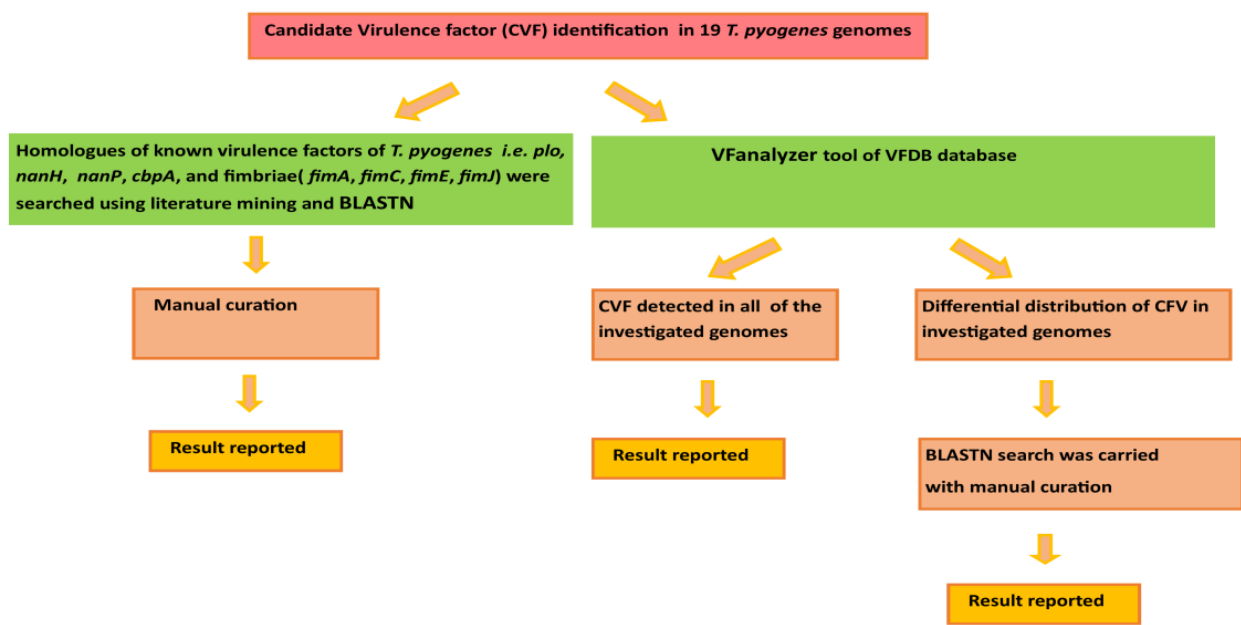
Figure 1. Overview of methodology implemented in identification of candidate virulence factors (CVF’s) in nineteen investigated T. pyogenes genomes. The first approach involved the detection of homologues of known virulence factors i.e., pyolysin ( plo ), collagen-binding protein A ( cbpA ), neuraminidases ( nanH and nanP ), and fimbriae ( fimA , fimC , fimE, and fimJ ) in the investigated genomes via using literature mining, BLASTN searches, and manual curation. The second approach involved utilization of the VFanalyzer tool of the VFDB database to detect homologues belonging to various classes of virulence factors.